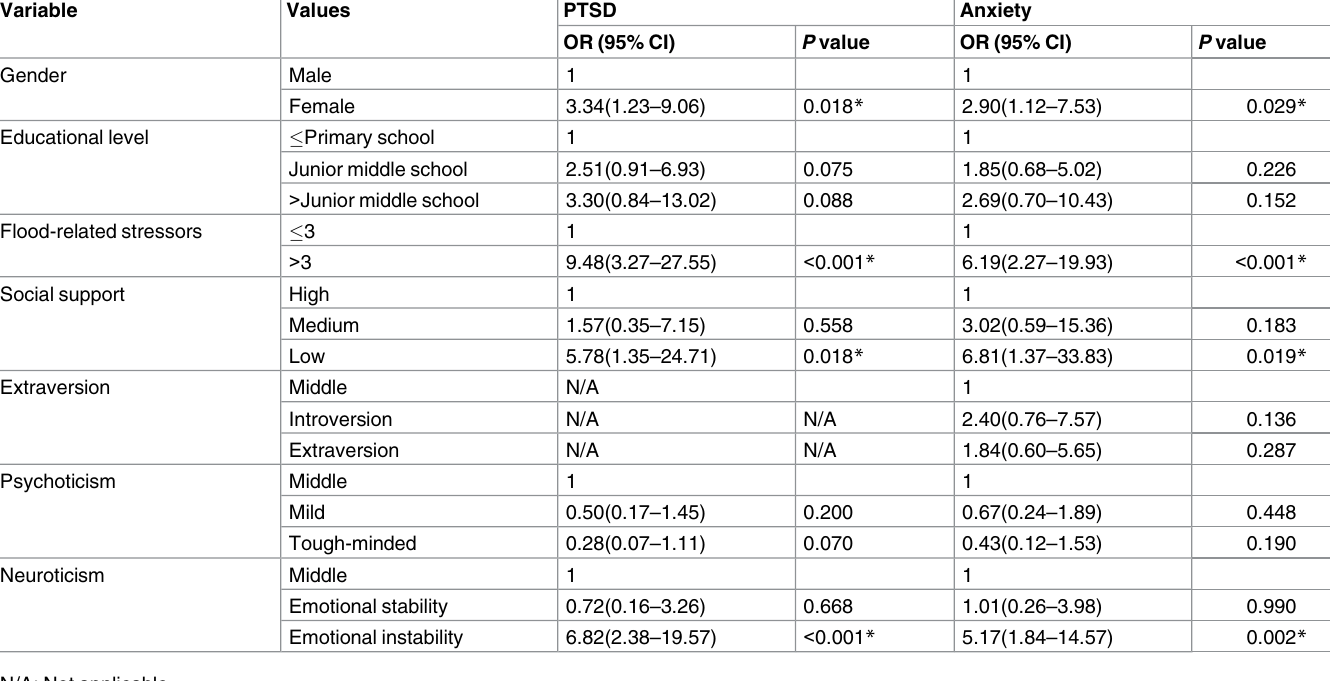
Table 3. Multivariable logistic regression analyses of the factors associatedwith PTSD and anxiety in the univariable analyses.